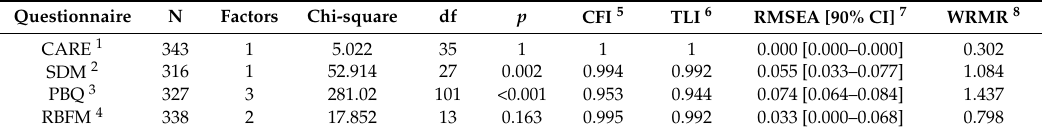
Table 1. Fit indices of Confirmatory Factor Analysis for each